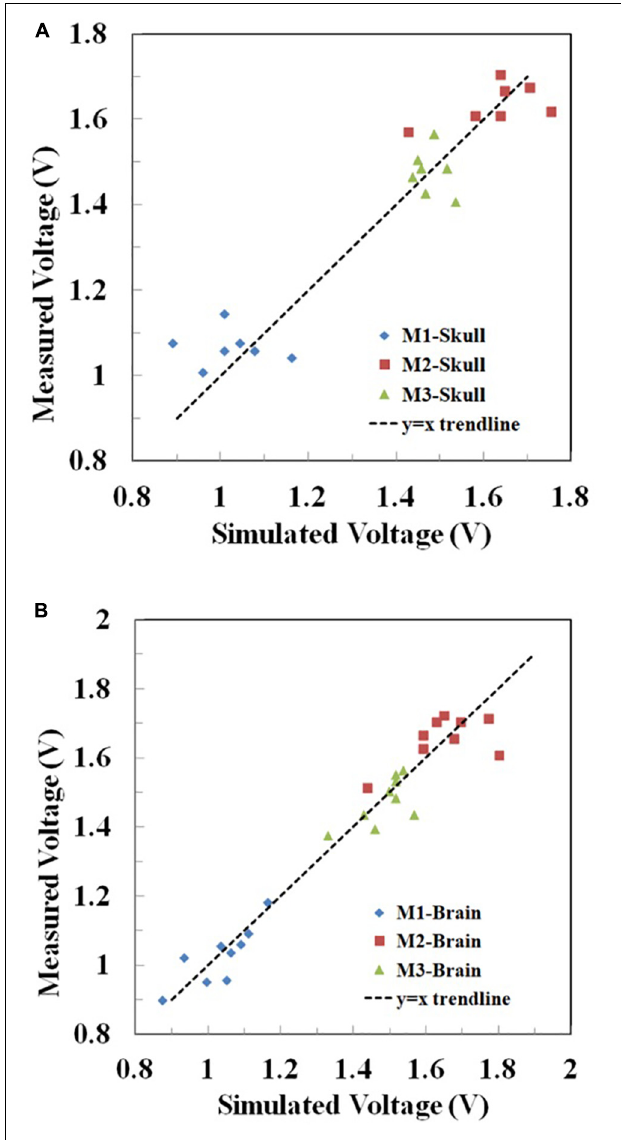
FIGURE 13 | Correlation between the measured and simulated voltages in the (A) skull and (B) brain layer in Montages 1–3 (M1-3) reflecting the montages in Figures 10–12 , respectively. The voltages at the two excitation electrodes were excluded for data analysis. For visual clarity, the y = x trendline was added in each